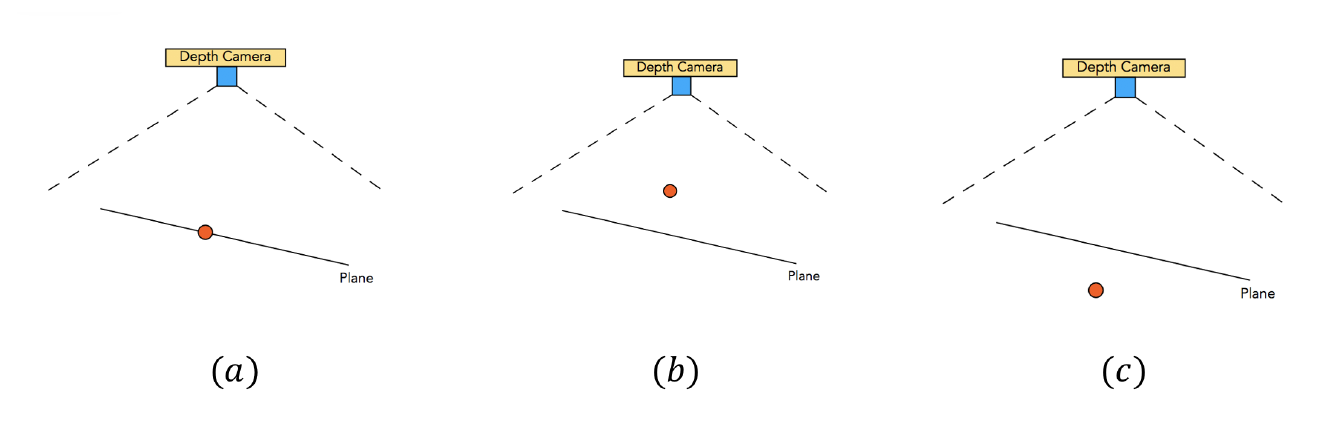
Figure 8. Positional relationship between point and plane: ( a ) on plane; ( b ) above the surface; ( c ) behind the